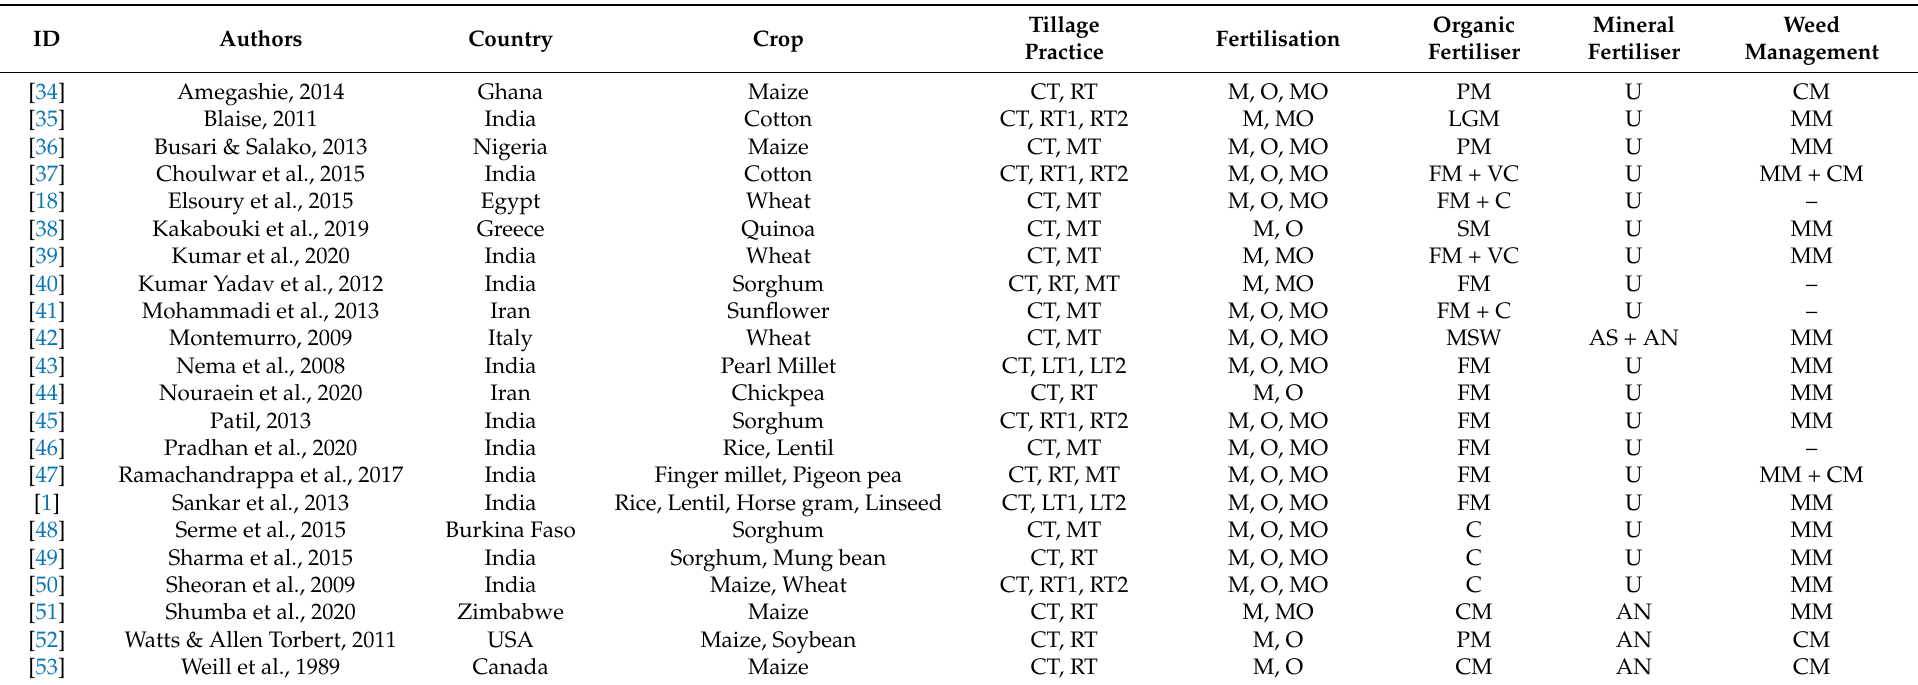
Table 1. The detailed information of selected studies and collected data. The data for authors, year, country, crop, soil tillage, and fertilisation sources. CT: conventional tillage, RT: reduced tillage, RT1: reduced tillage 1, RT2: reduced tillage 2, MT: minimum tillage, LT: low tillage, LT1: low tillage 1, LT2: low tillage 2, M: inorganic fertilisation, O: organic fertilisation, MO: mixed inorganic + organic fertilisation; PM: Poultry manure; LGM: Legume green manure; FM: Farmyard manure; VC: Vermicompost; C: Compost; SM: Sheep manure; MSW: Municipal solid waste; CM: Cattle manure; U: Urea; AS: Ammonium sulphate; AN: Ammonium nitrate; CM; Chemical weed control; MM: Mechanical weed